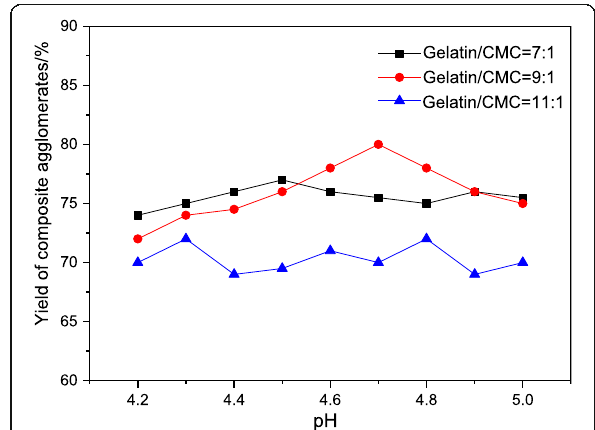
Fig. 2 The impact of gelatin/CMC ratio and pH value on the yields of composite